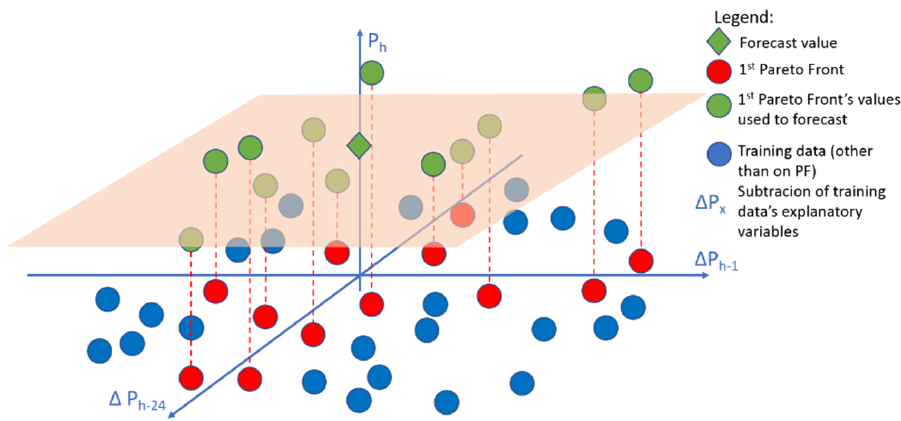
Figure 7. Example of choosing data belonging to the first, the second, and the third Pareto fronts in all four quadrants.